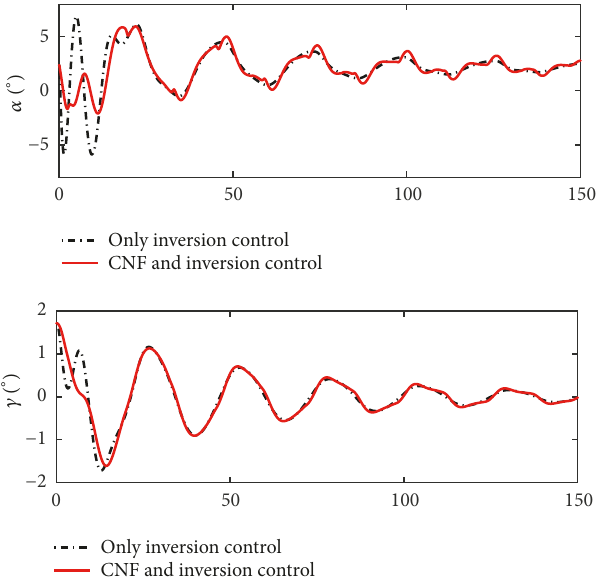
Figure 9: Angle of attack and flight path angle between with CNF and without CNF.